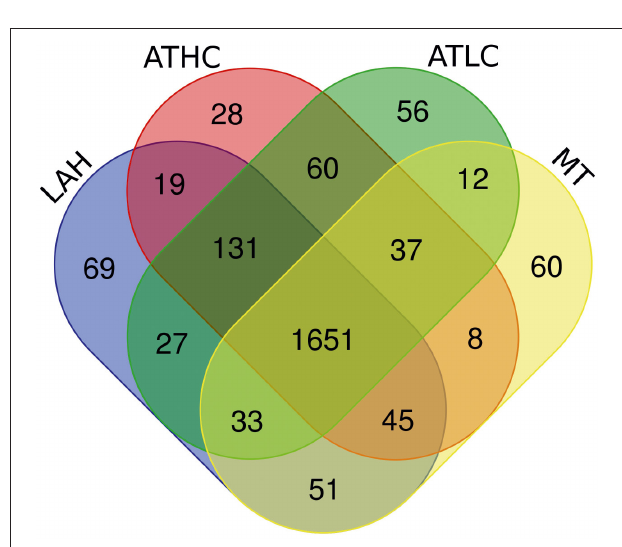
FIGURE 2 | Venn diagram showing the number of proteins identified under the four growth conditions, ATLC, ATHC, MT, and